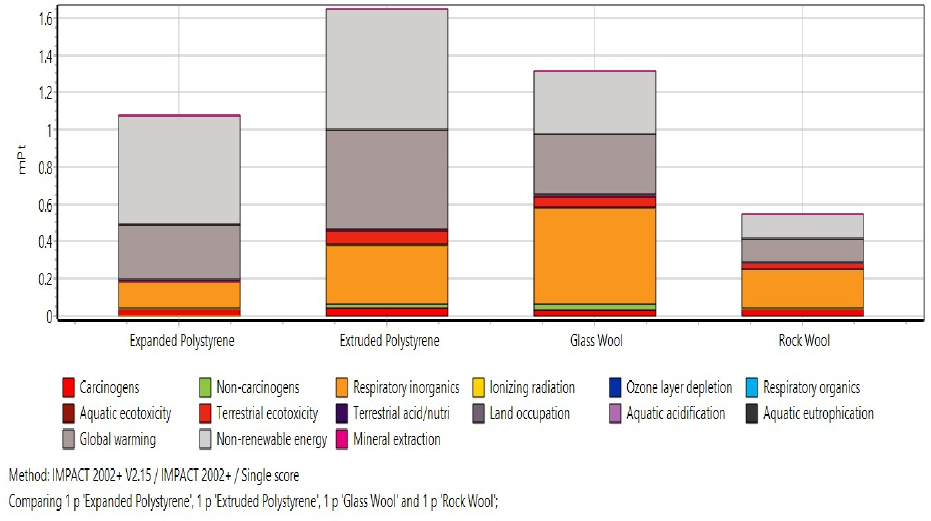
Figure 10. Midpoint environmental impact results.